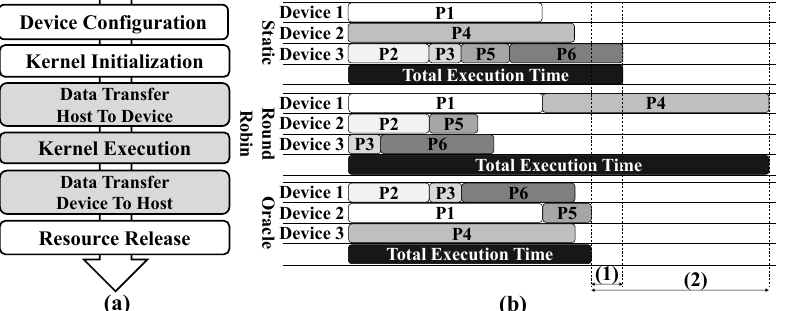
Figure 2. ( a ) A typical OpenCL program flow and ( b ) examples of execution scenarios with various allocation